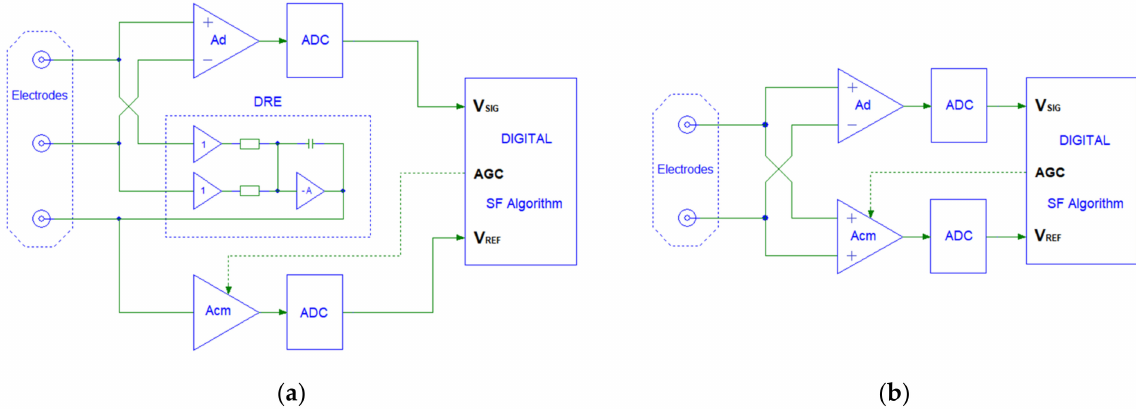
Figure 1. Biopotential readout circuits for synchronous filtering with ( a ) and without ( b ) a driven reference electrode (DRE)